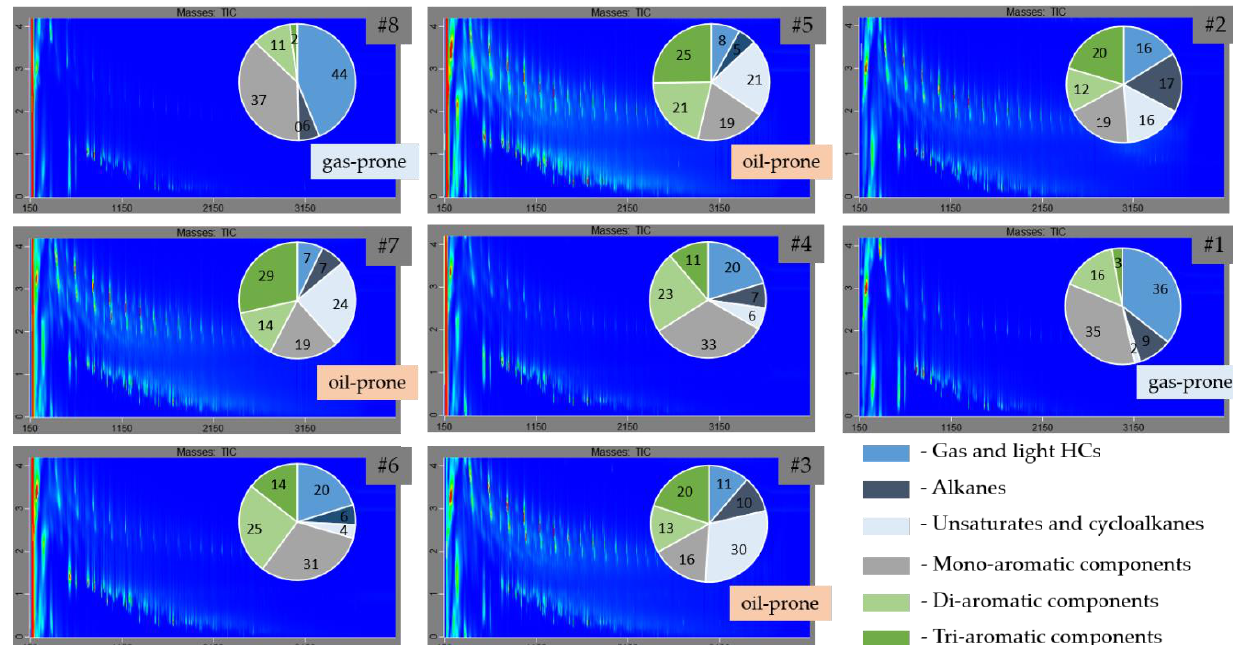
Figure 13. Relations between the Th/U ratio (logarithmic scale) and the isotope composition of organic matter ( a ) and Nd ( b ). The two series of samples represent TOC < 5 wt.% (blue) and TOC >5 wt.% (red markers), and numbers correspond to geochemical members.